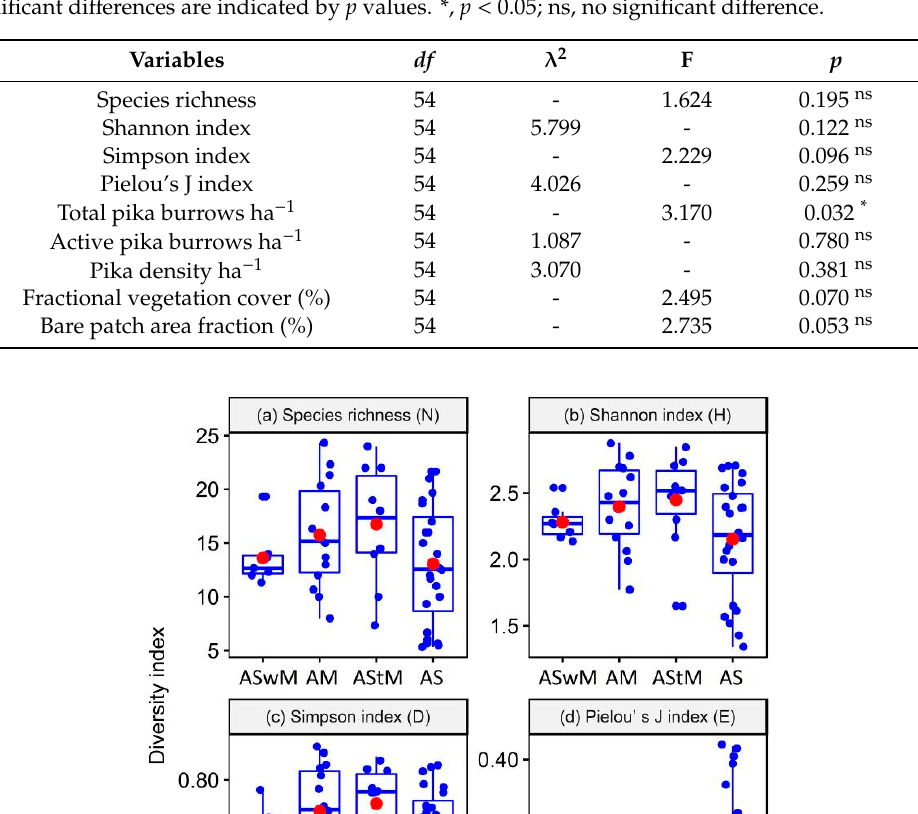
Table 2. One-way ANOVA of pika burrows, pika density, vegetation richness indexes, fractional vegetation cover and bare patch area fraction among four types of alpine grasslands at plot scale.